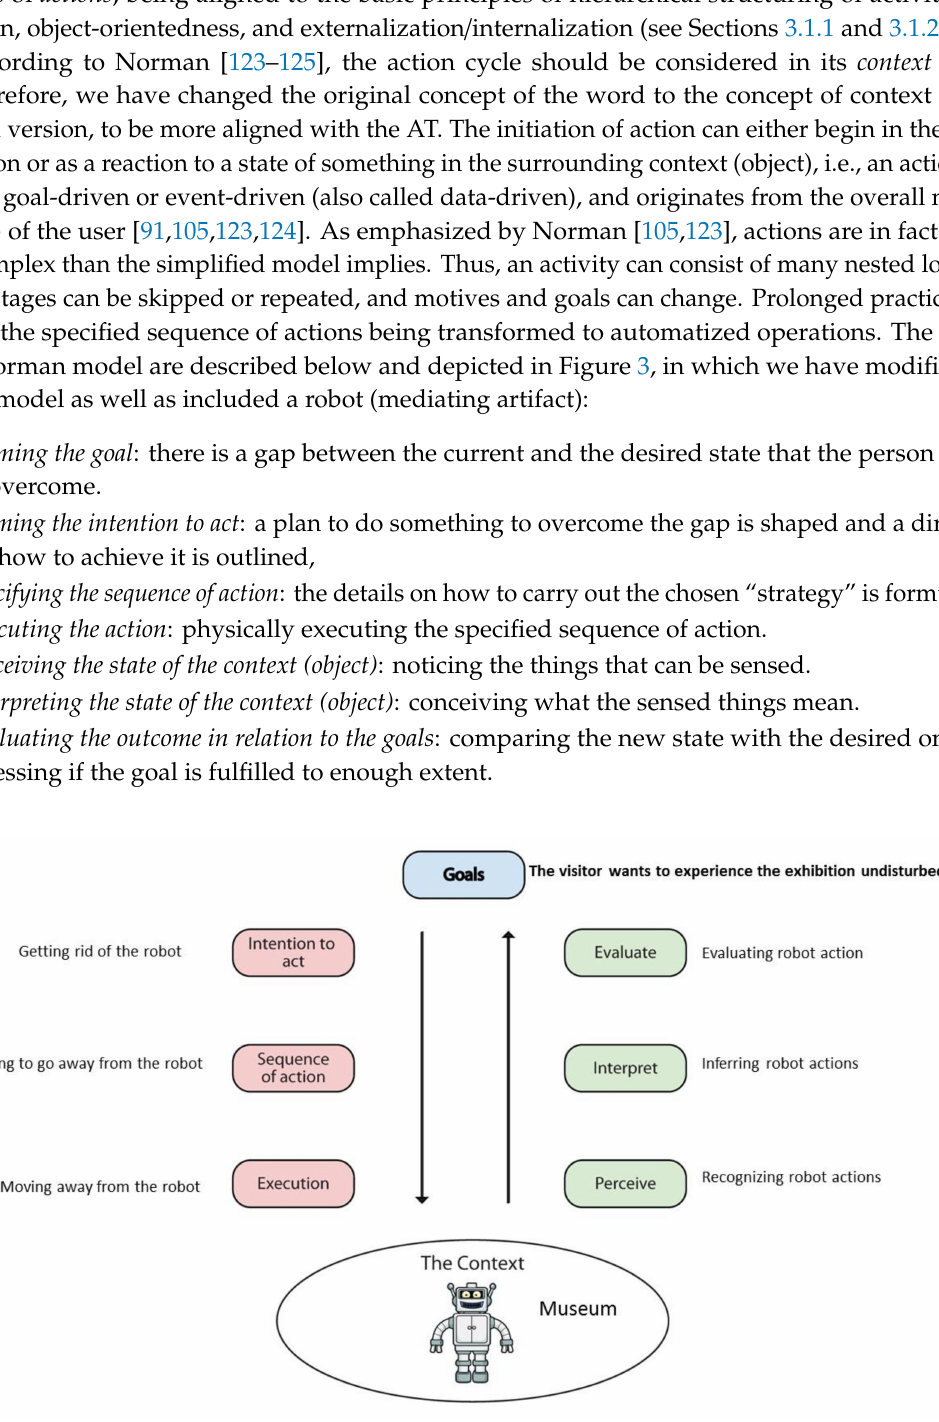
Figure 3. The modified seven stages of action model including a robot (modified from